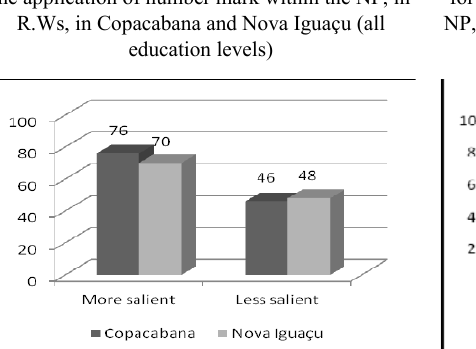
Figure 12. Actuation of the Phonic Salience for the application of number mark within the NP, in